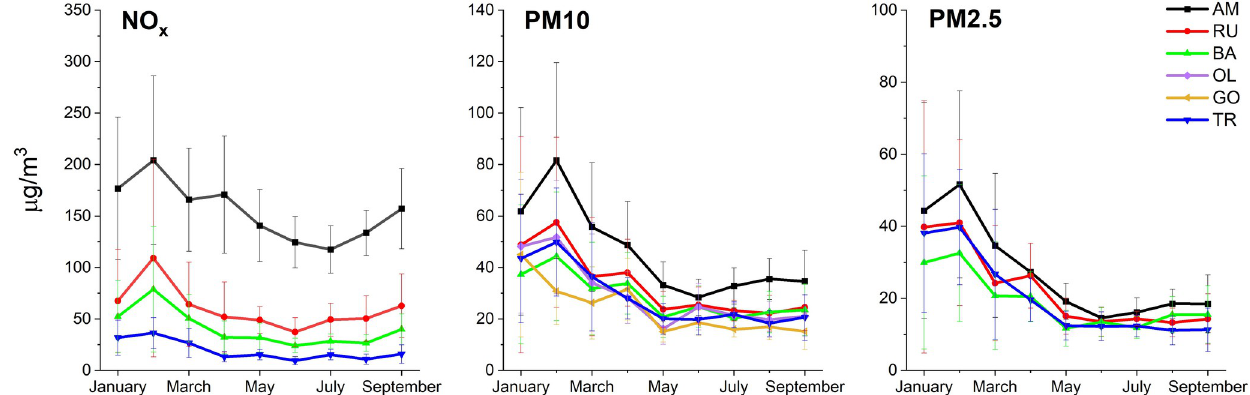
Fig 1. Influence of the growth position in Malopolska region on the values of the parameters characterizing the physiological state of Betula pendula plants. A . Changes in the maximum quantum yield of photosystem II (Fv/Fm) in leaves. B . Differences in the efficiency of the water splitting complex on the photosystem II donor side (Fv/F 0 ). C . Discrimination of 13 C carbon isotope in inflorescences of B . pendula plants. Average values ( ± SD) marked with the same letters do not differ significantly according to Duncan’s test, p � 0,05. RU–Ruczaj, BA–Batowice, AM–al. Mickiewicza, OL–Olkusz, TR–Trzebinia, GO- Gorlice,